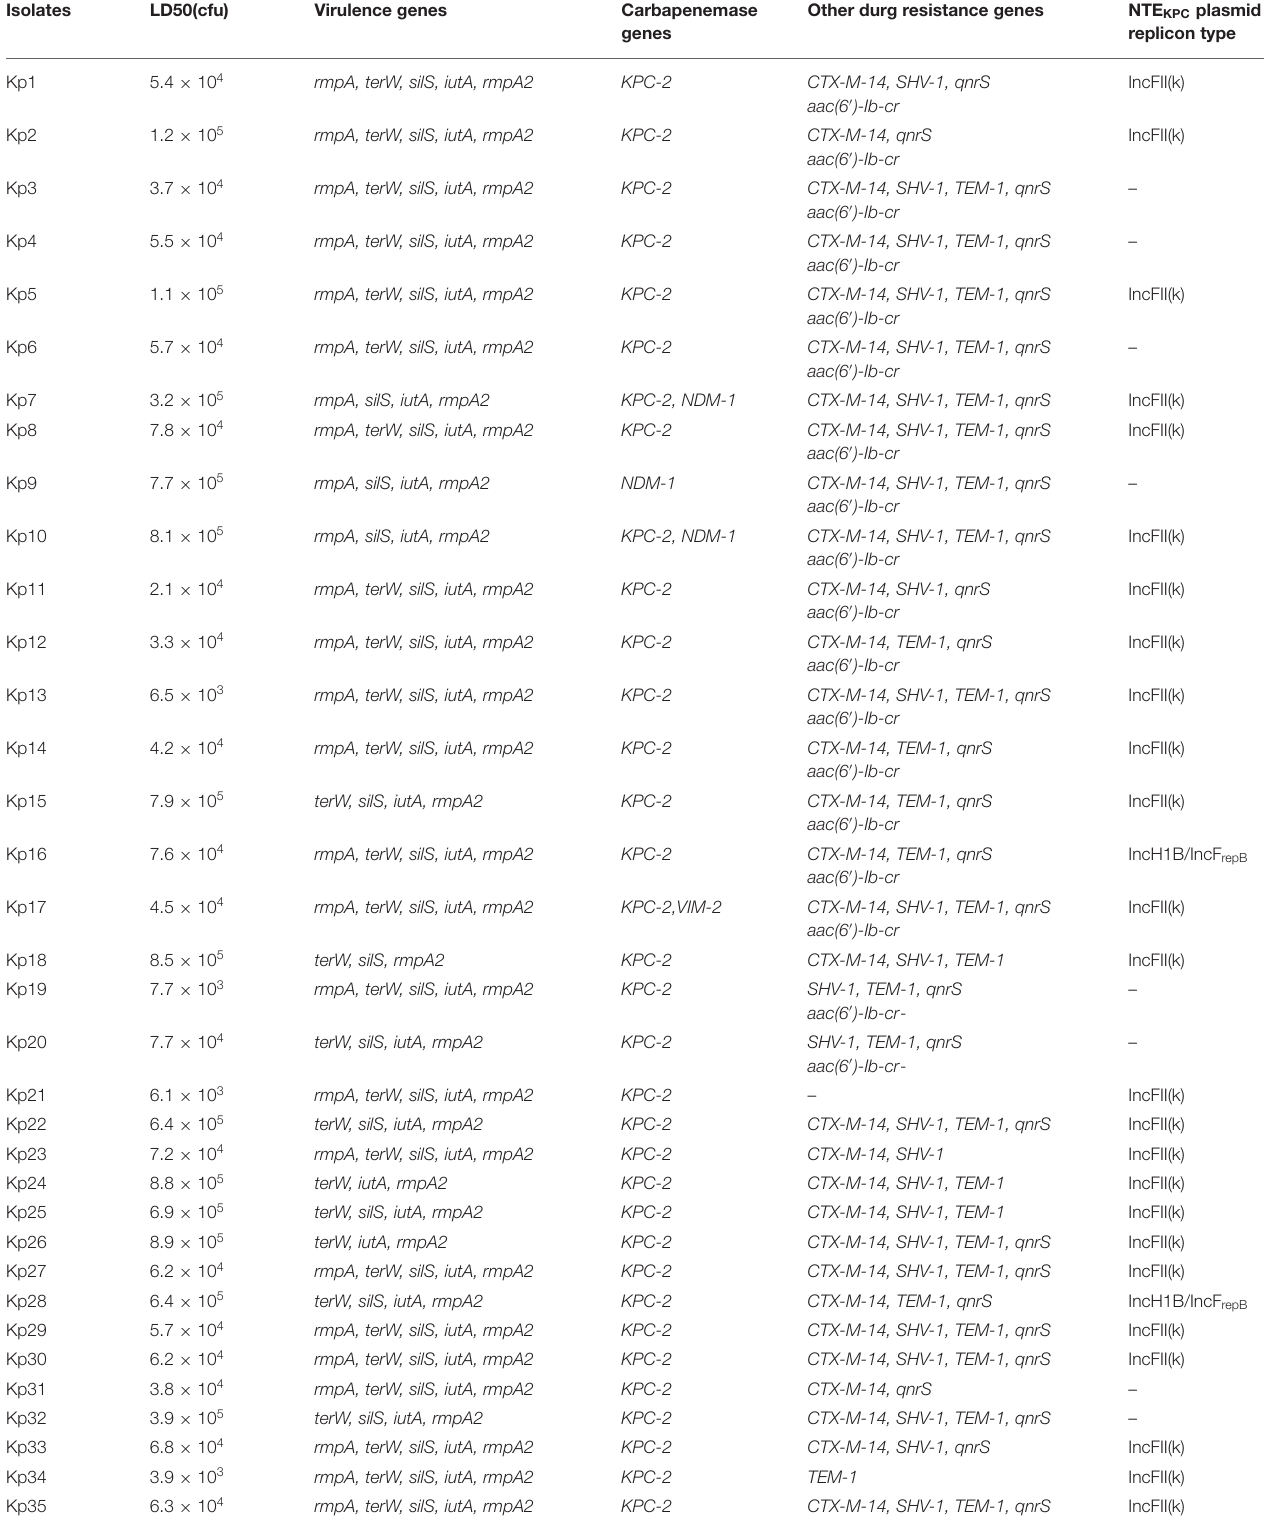
TABLE 1 | Main molecular features of all the CR-hvKP isolates.